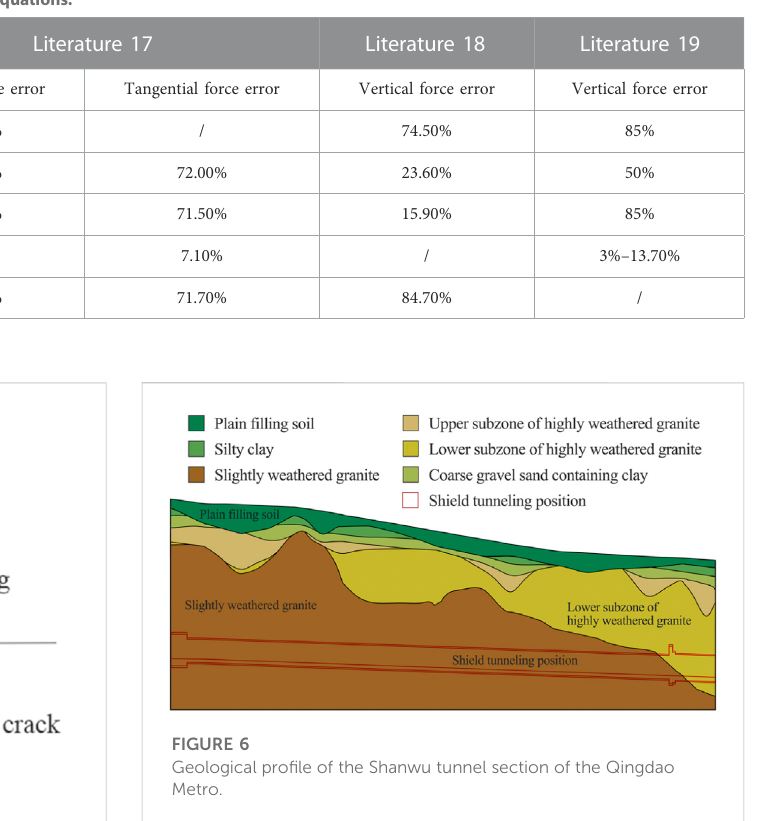
TABLE 1 The relative error of the disc cutter force prediction equations.